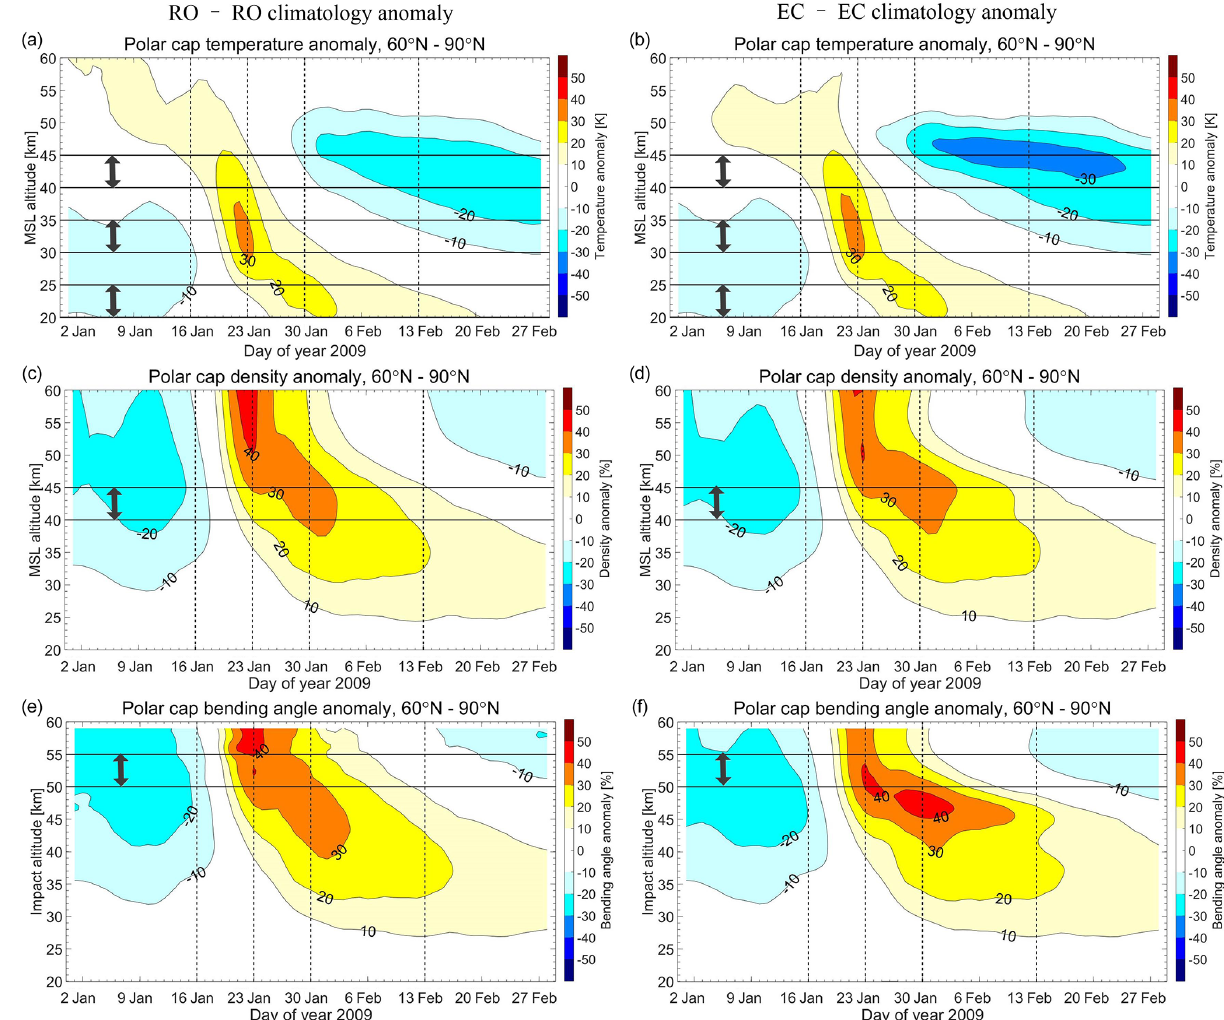
Figure 4. Temporal evolution of polar-cap (60–90 ◦ N) mean temperature (a, b) , density (c, d) , and bending angle (e, f) anomaly profiles from RO (a, c, e) , complemented by the corresponding anomalies from the ECMWF analysis data (b, d, f) . The vertical dashed lines indicate 4d selected for showing anomaly distributions in Fig. 5, and the horizontal lines in the panels delineate those altitude layers chosen for the respective variables to help compute the TEA metrics as presented in Fig.